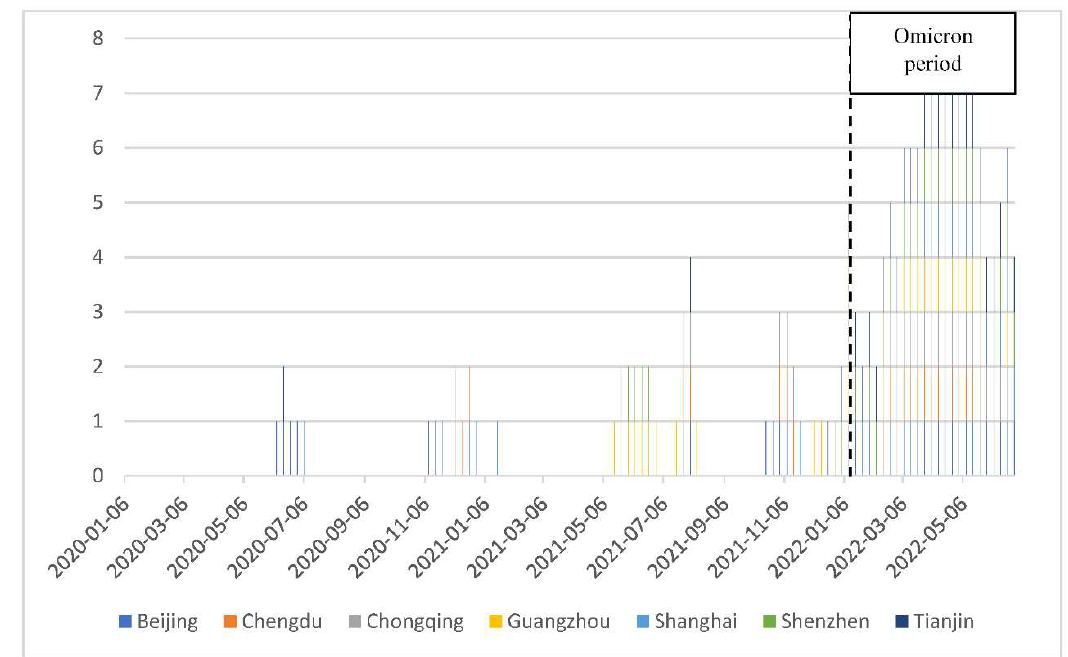
Figure 2. Weekly COVID-19 Exposure in 7 Chinese cities (Baidu Search Index). Table 2. Descriptive statistics of key variables.